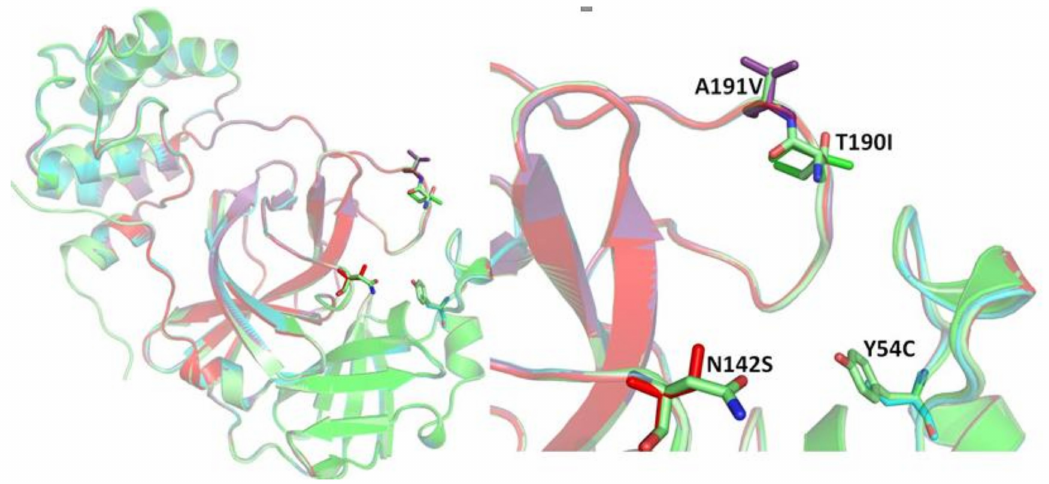
Figure 2. The selected mutant investigated in this